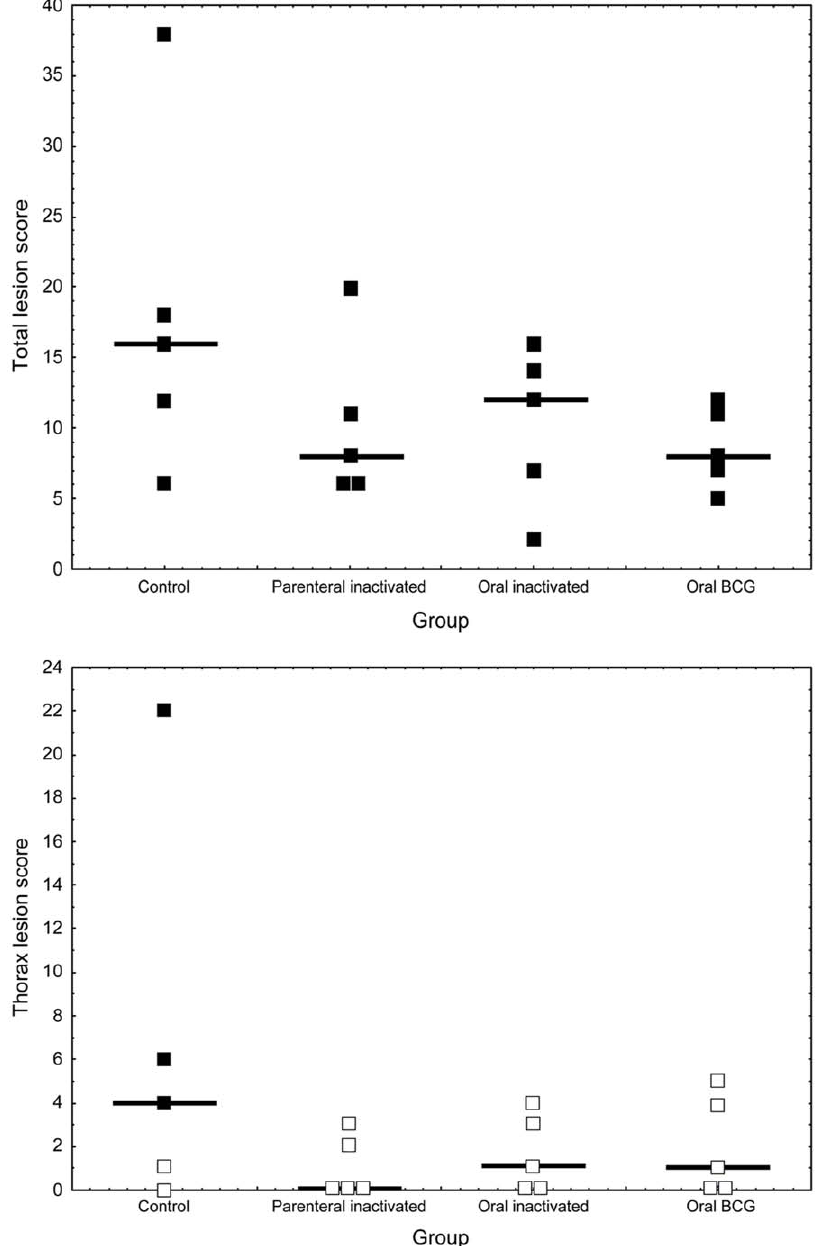
Figure 1. Wild boar TB lesion scores at necropsy. Total lesion score (upper panel) and thorax lesion score (lower panel) for 20 wild boar used in the vaccination and challenge experiments. The solid lines show the median values. In the lower panel, solid squares indicate animals with massive Mycobacterium bovis growth ( . 50 colonies) from thoracic samples.